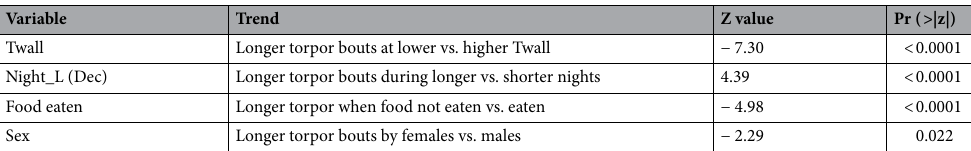
Table 2. Generalized linear mixed model on the effects of ambient temperature (Twall), night length (Night L), food intake and sex on torpor bout